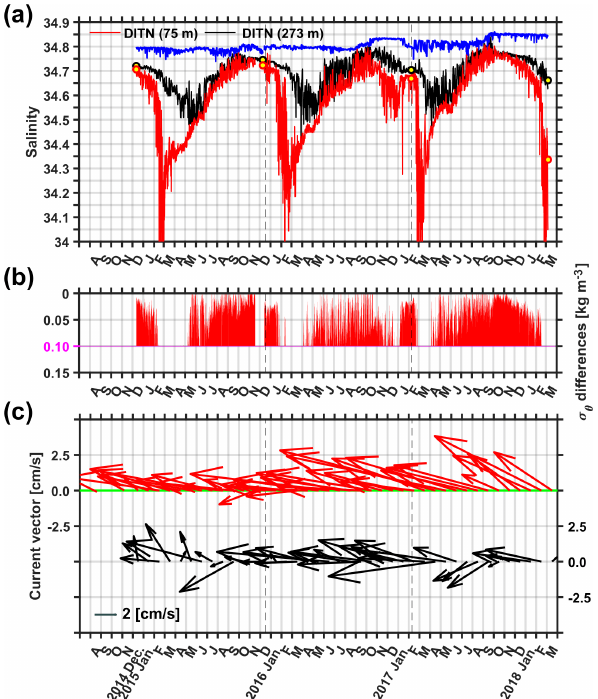
Figure 8. (a) Salinity time series at three depths from the DITN. The red (black) circles filled with yellow are the averaged salinity in a 5m layer at 75m (273m) obtained using CTD data collected near the DITN. The black dashed line divides periods of each leg at the moorings (see details in Table 1). (b) Potential density ( σ θ ) dif- ferences lower than 0.10kgm − 3 for σ θ at 75 and 273m are shown. The magenta line indicates a 0.10kgm − 3 difference. (c) Monthly mean current vectors at 75 and 273m of the DITN are indicated by red and black